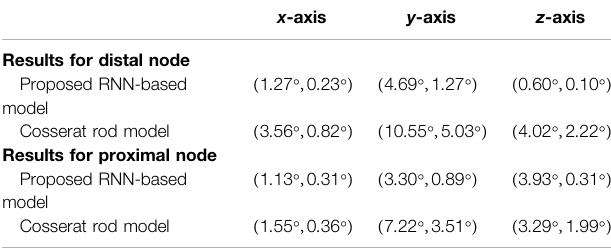
TABLE 1| The maximum and mean absolute errors around the x , y , and z -axes in ordered pairs for the distal and proximal nodes. x -axis y -axis z -axis